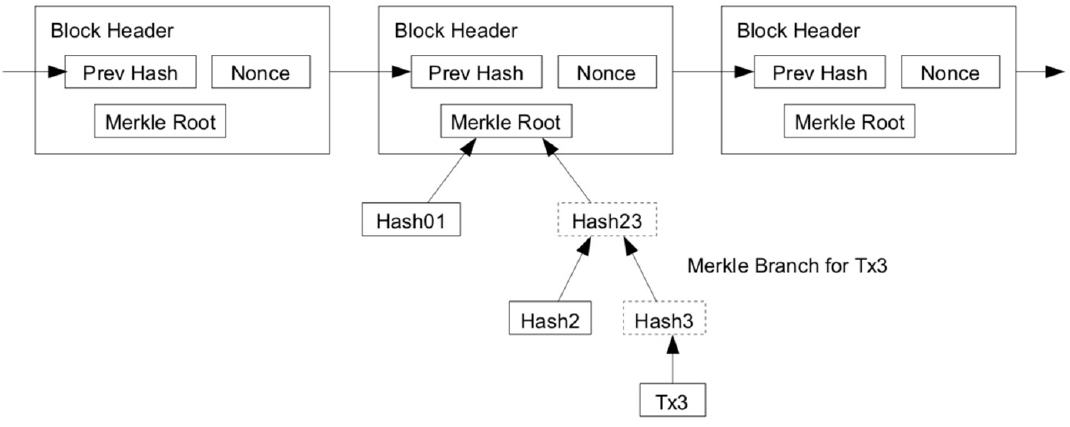
Figure 2. Idea of light